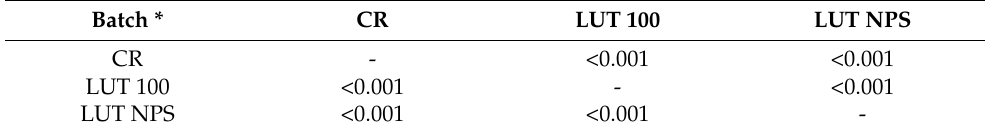
Table 3. Comparison of post hoc OXSR1 results (mg/mg protein) with regard to the batches of the studied OSSC cell lines (Lut 100—oral cancer squamous cells incubated with lutein (100 mg); Lut Nps—oral cancer squamous cells incubated with lutein nanoparticles; CR—control oral cancer squamous